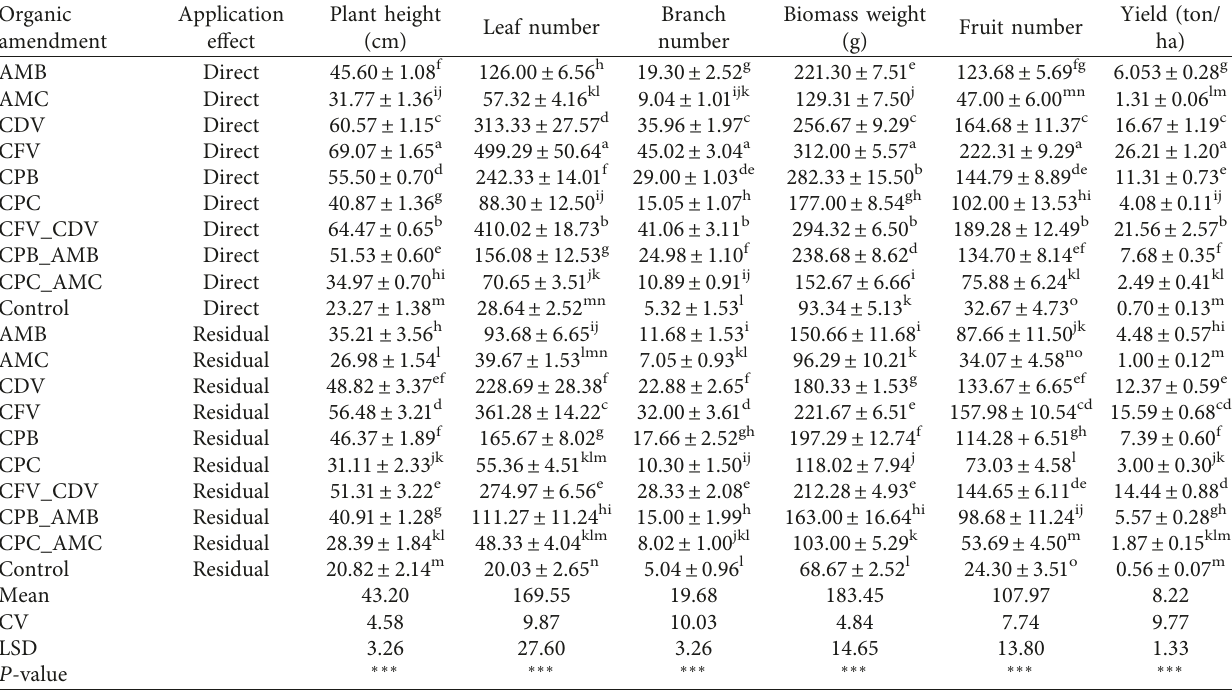
Table 1: Interaction effect of organic amendment and application effect on hot pepper plant height, leaf number, branch number, biomass weight, fruit number, and